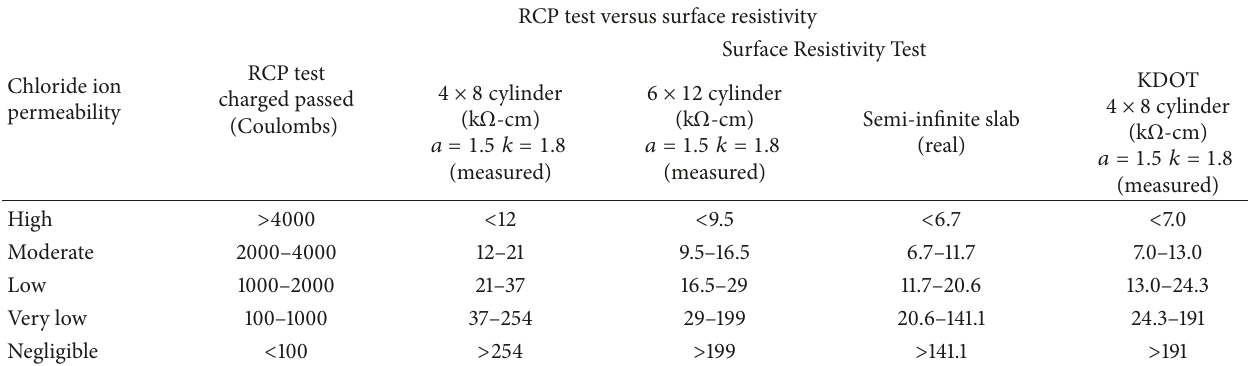
Table 5: Classification of concrete permeability to surface resistivity